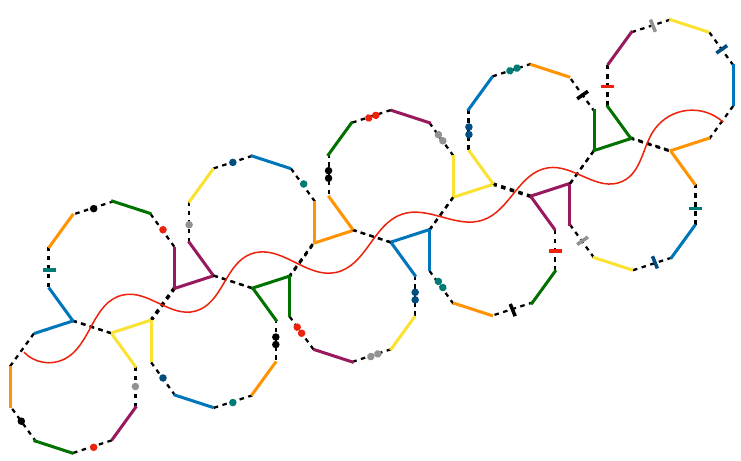
Figure 18 . A choice of gluing for five boundary regions. The geometry is that of a torus, but now with many disconnected boundary regions.